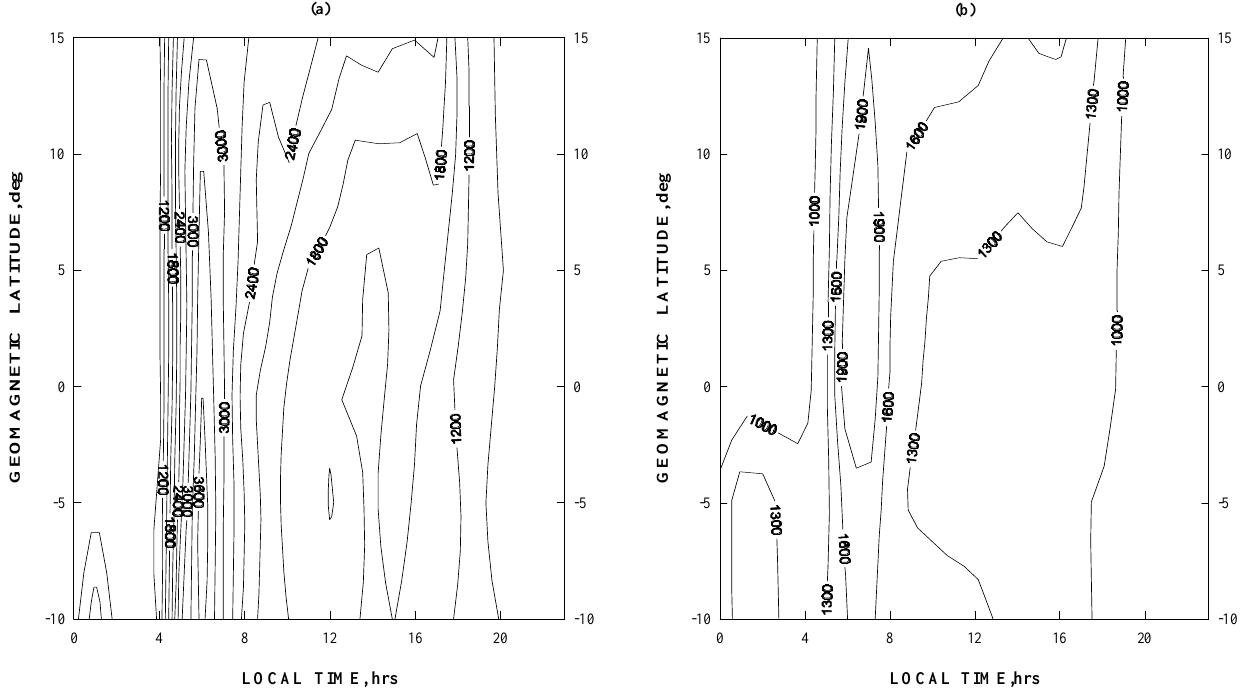
Fig. 4. Latitudinal and diurnal variation of electron temperature at ∼ 500km for (a) observed (b) IRI in northern winter.